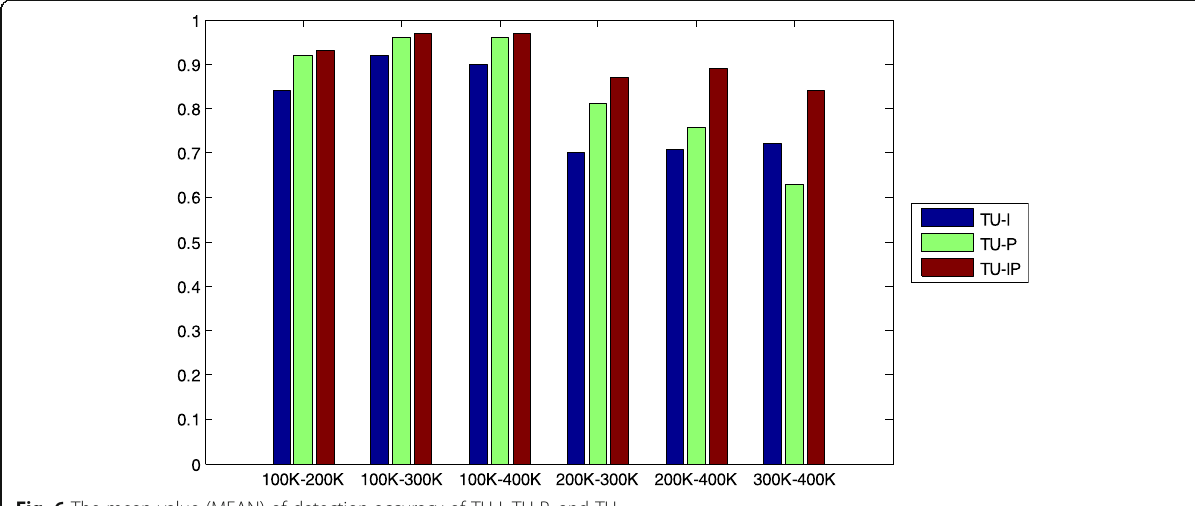
Fig. 6 The mean value (MEAN) of detection accuracy of TU-I, TU-P, and TU